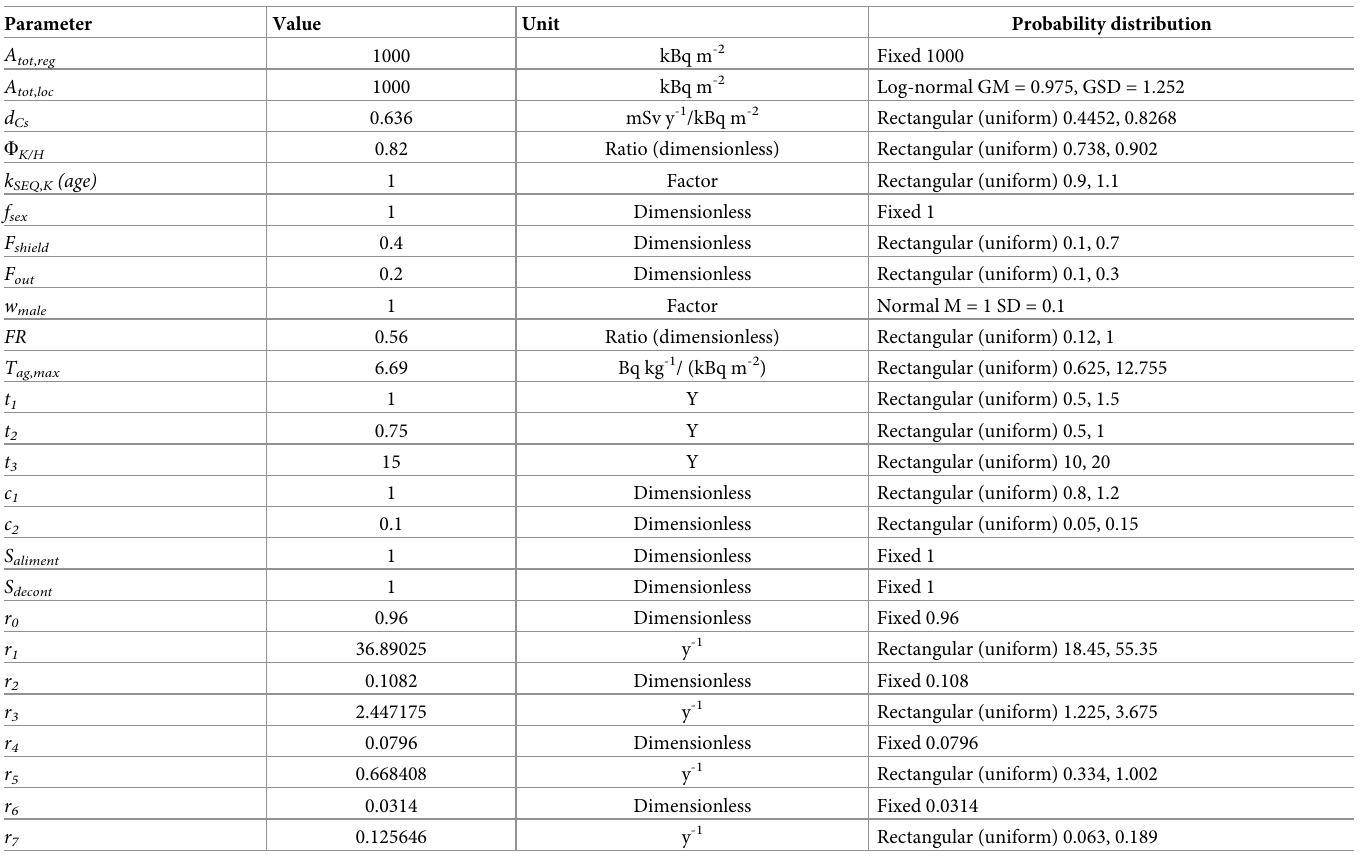
Table 8. Parameter values and probability density functions (pdfs) used in the uncertainty assessment. Central estimates of parameters were those used in the stan- dard scenario. The choice of pdfs and assigned distribution parameters are largely based on qualified assumptions (Type B uncertainties), to a large part presented in Isaksson et al. (2019)